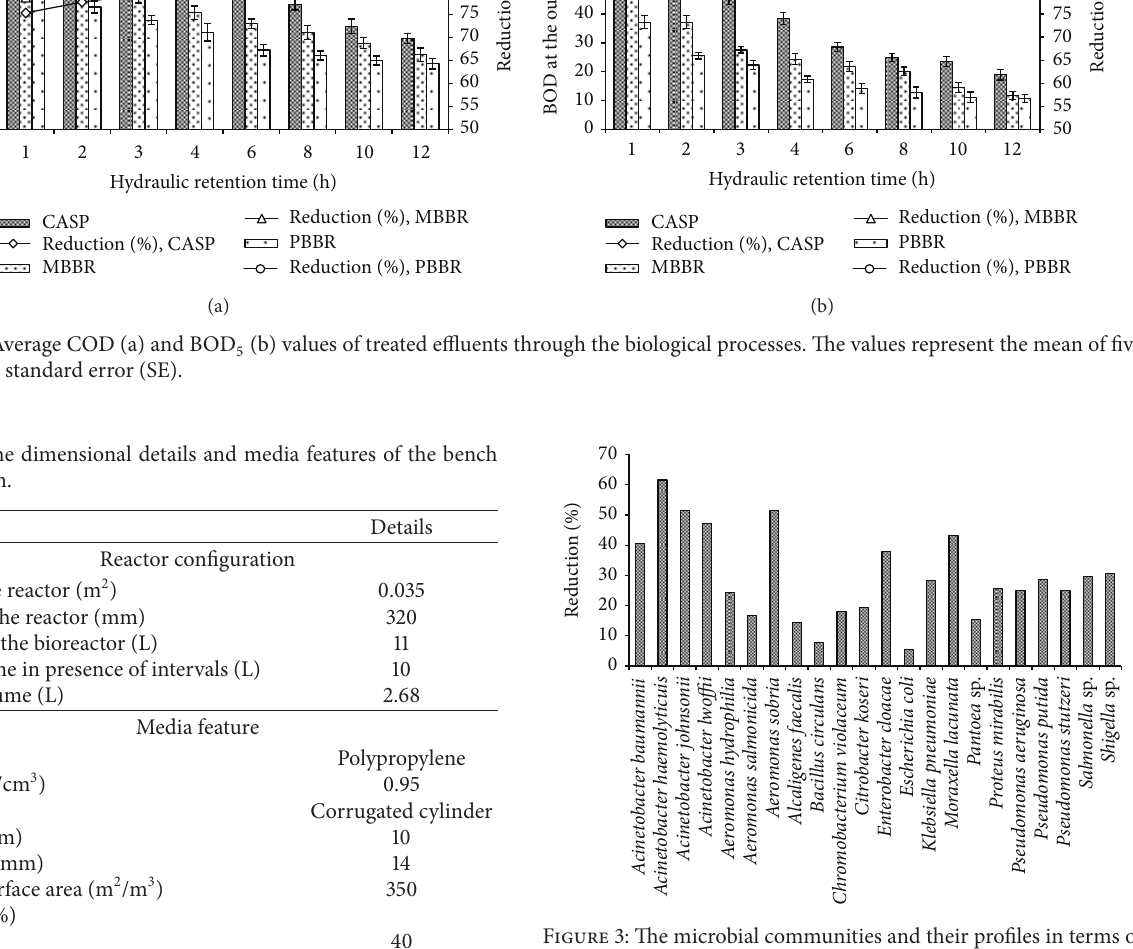
Figure 3: The microbial communities and their profiles in terms of average percentage removal of chemical oxygen demand